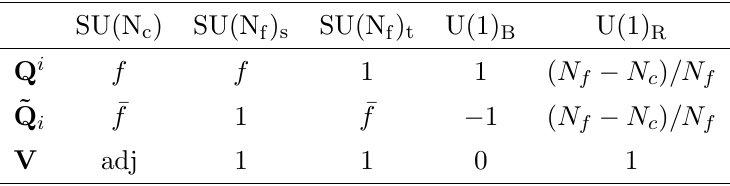
Table 1 . The matter content of electric N = 1 SQCD.